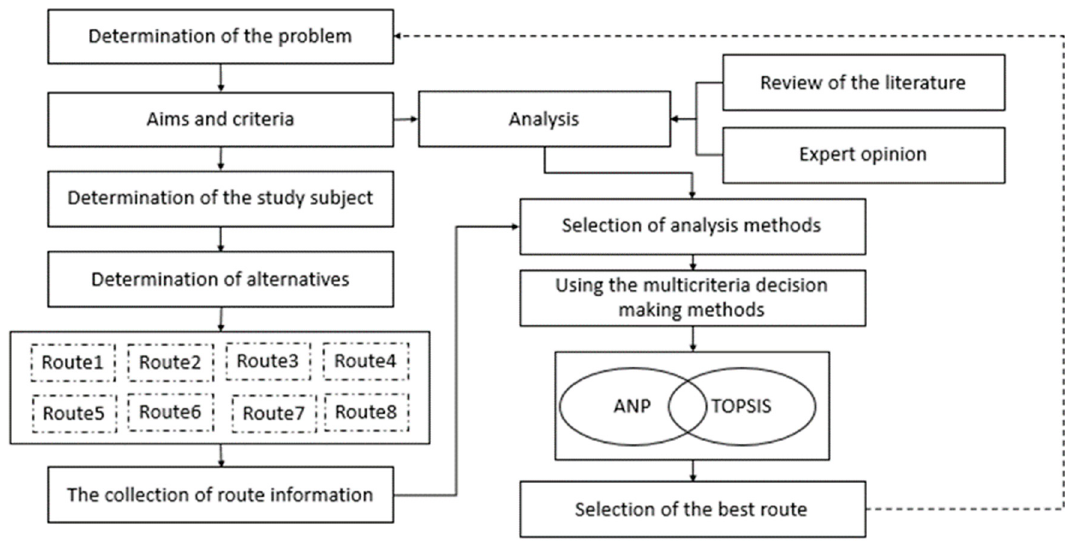
Figure 1. Research Figure 1. Research methodology.